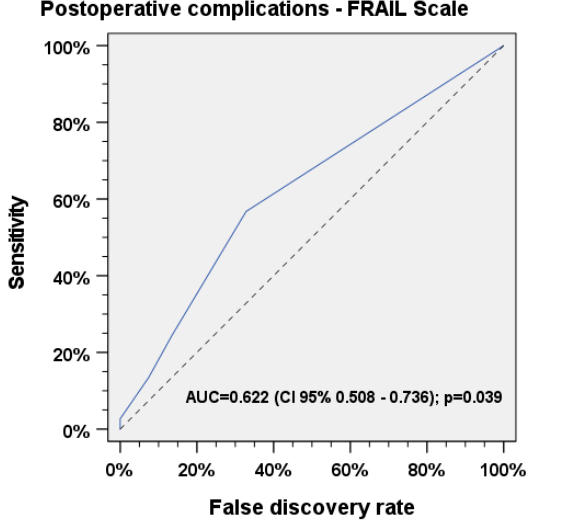
( b ) Figure 2. Receiver operating characteristic (ROC) analysis for ( a ) any and ( b ) severe postoperative complications vs. G8 questionnaire.